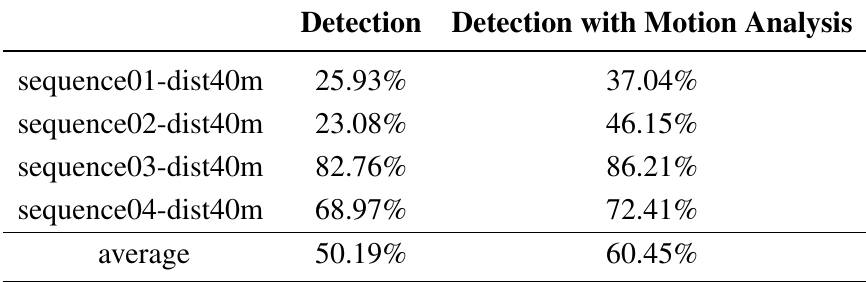
Table 6. Mean value of correct first detections at distances up to 40